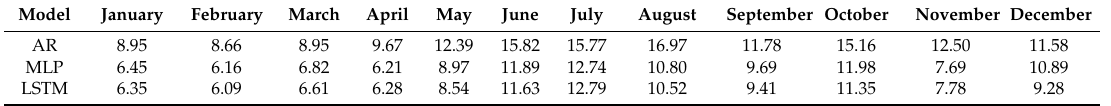
Table 4. Comparison of monthly root mean square errors (RMSE) values for the short-term predictions.